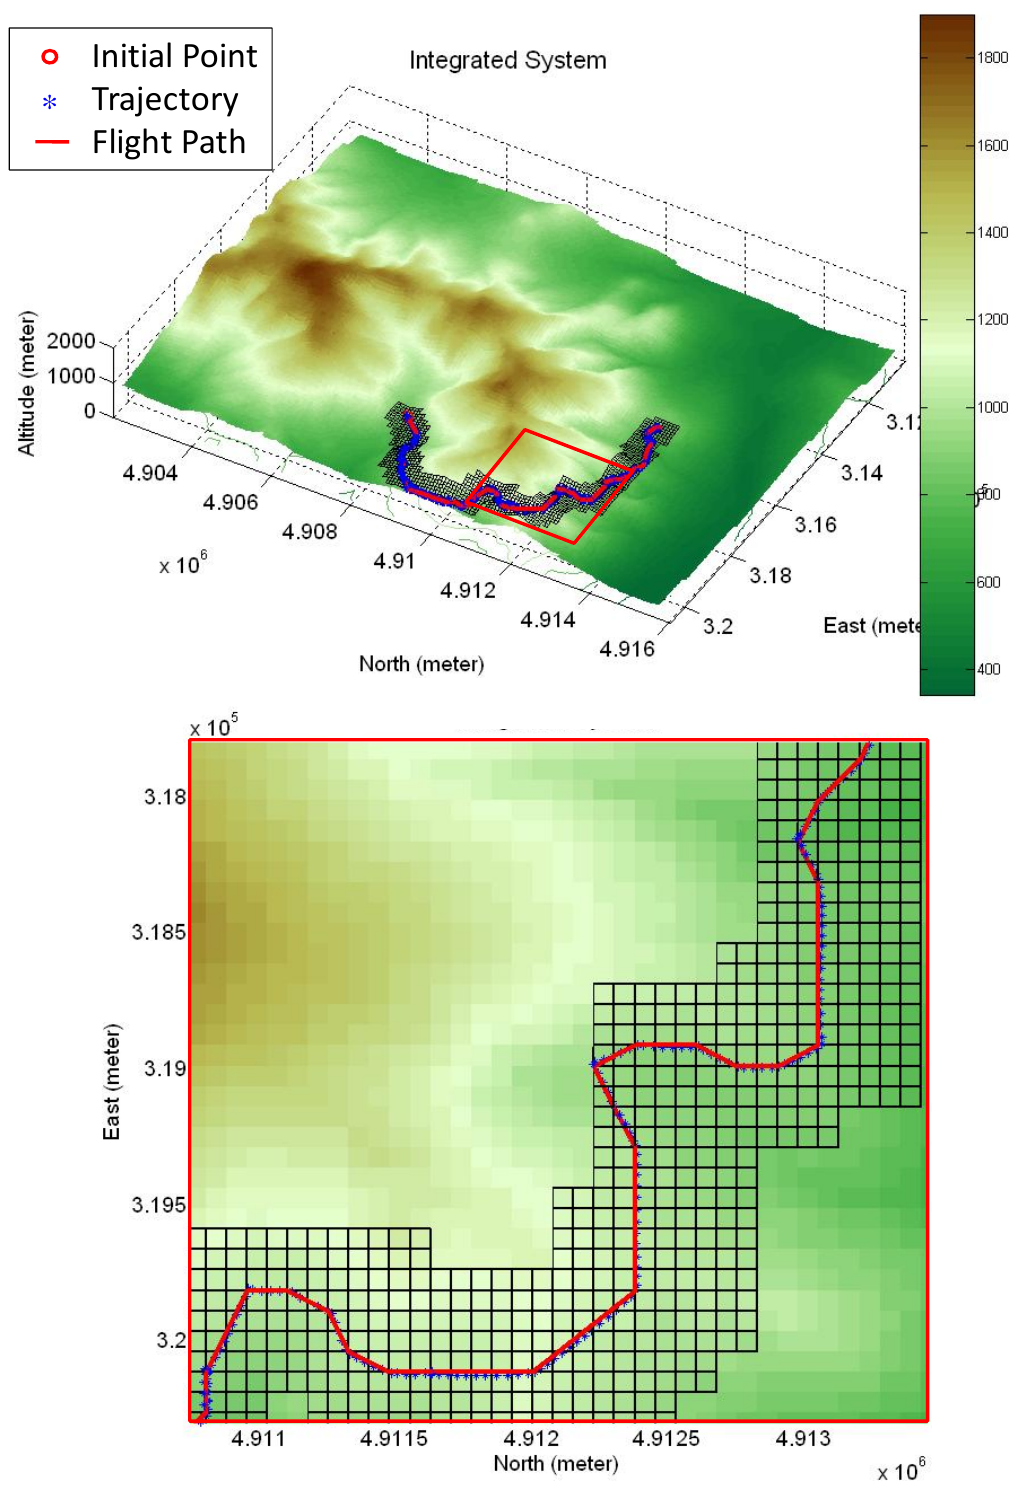
Figure 21. The test result of the integrated